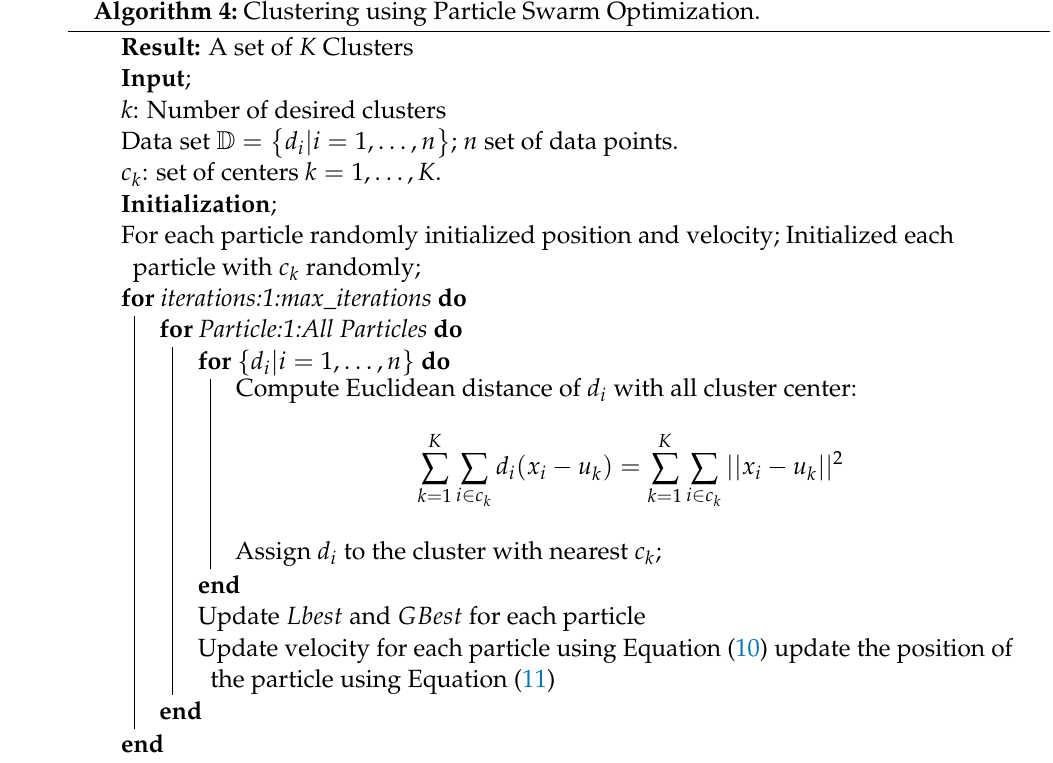
Algorithm 4: Clustering using Particle Swarm